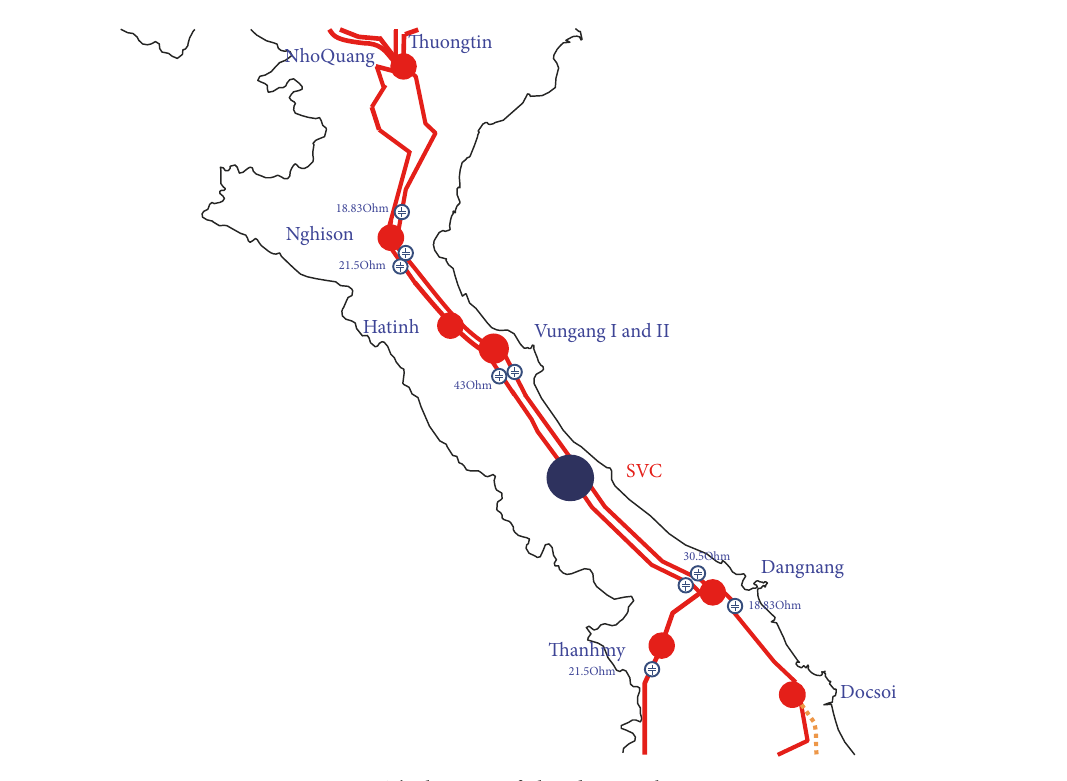
Figure 16: The location of placed SVC substation.